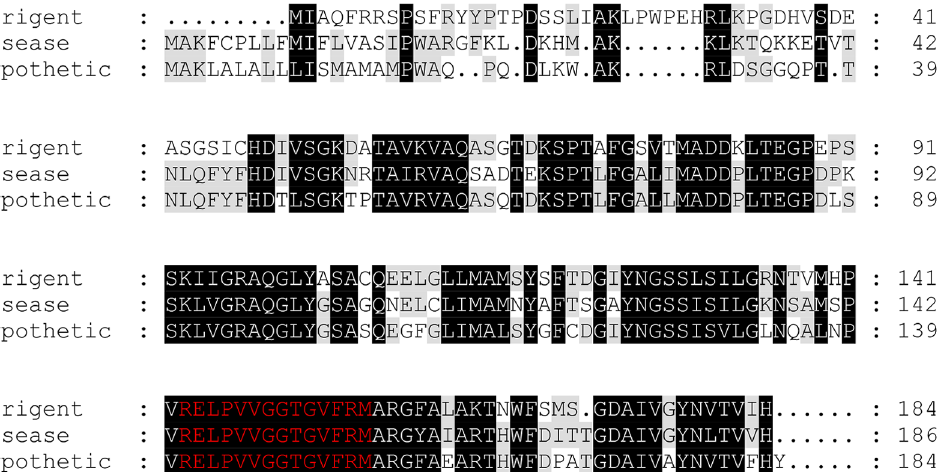
Figure 7. Sequence homologies. A sequence alignment of the dirigent- related protein ( Tamarix androssowii ), disease-response protein of Ricinus communis and the hypothetical disease-resistance protein of Vitis vinifera showing regions of similarity (black highlight), including the conserved domain which indicate 100% homology to the 31 kDa protein found in honey (red letters). doi:10.1371/journal.pone.0072897.g007 PLOS ONE |